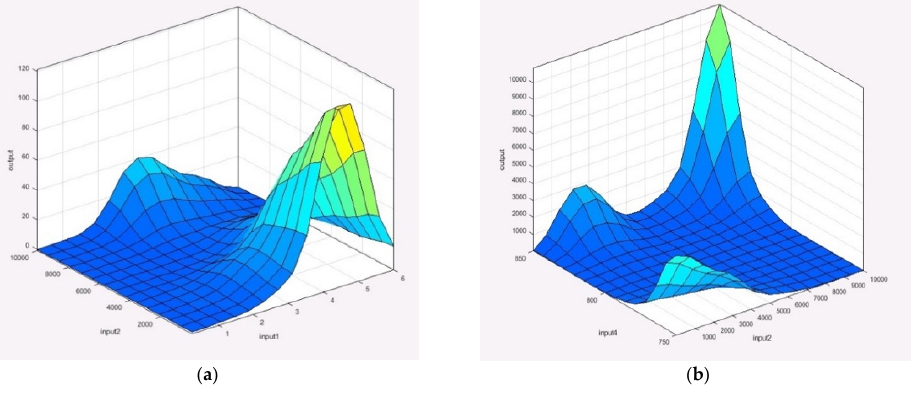
Figure 8. The results of the prediction of oil penetration with ANFIS.